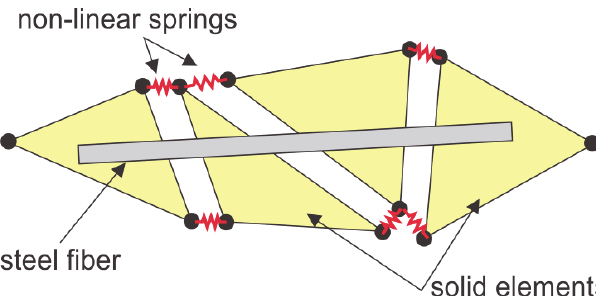
Figure 2: Steel fiber modeling by non-linear springs.